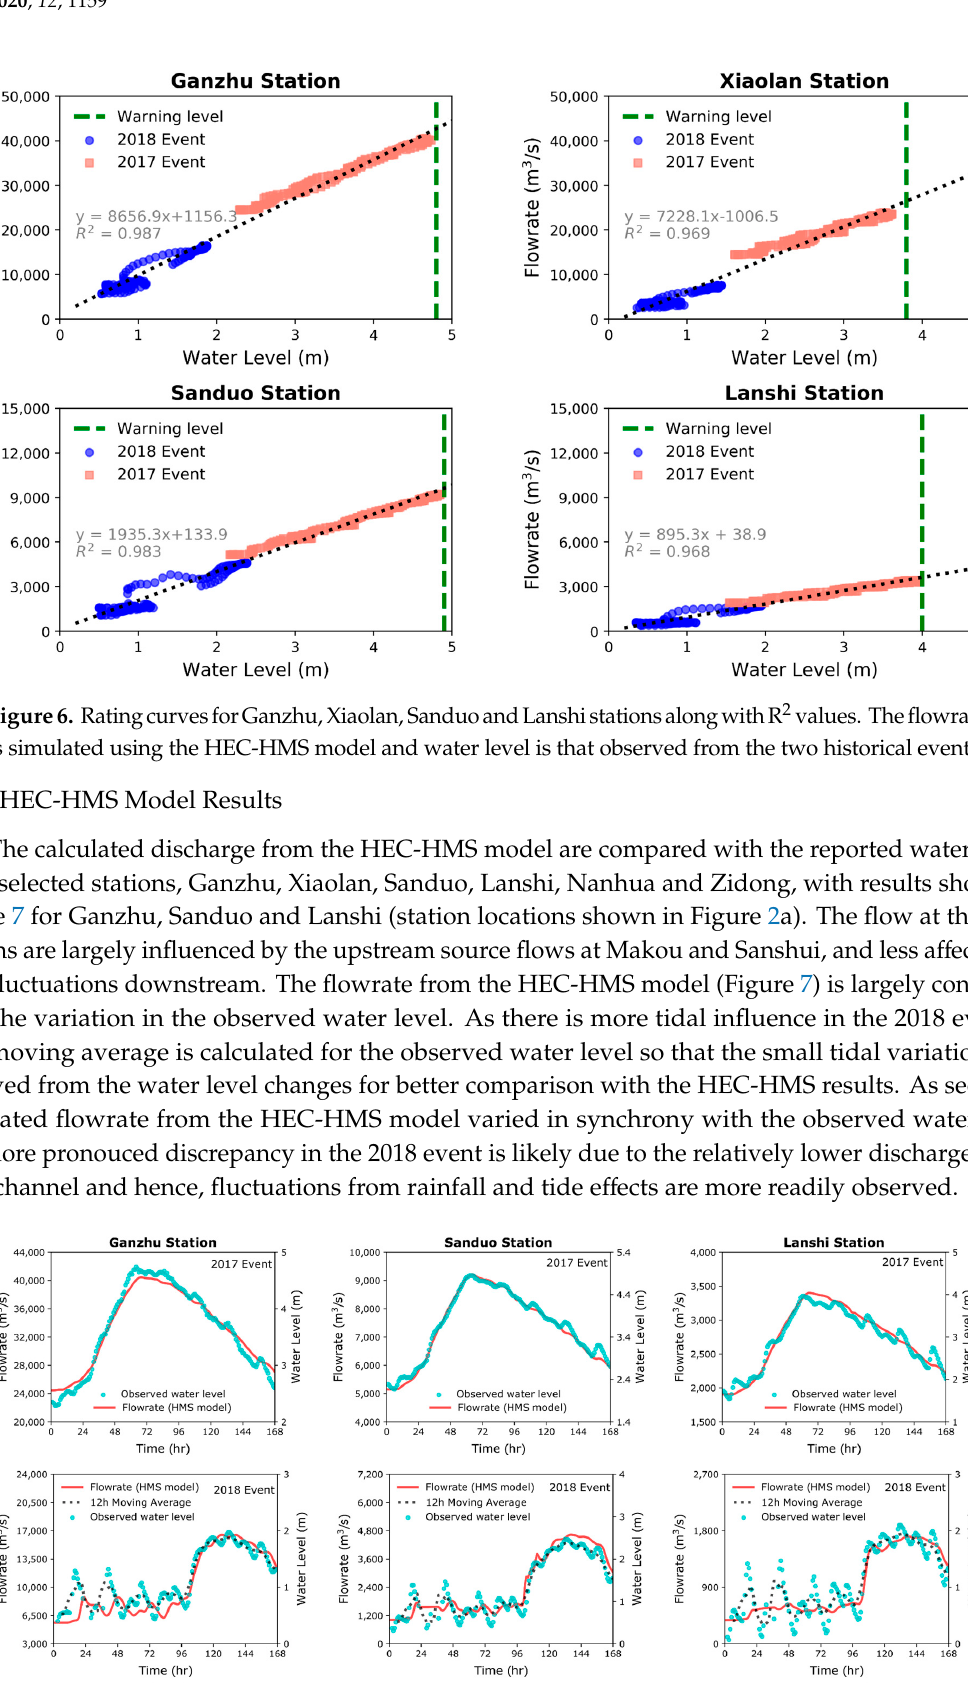
Figure 7. Comparison of the calculated discharge from the HEC-HMS model and observed water level for the two historical events: 2017 event (top panel) and 2018 event (bottom panel).